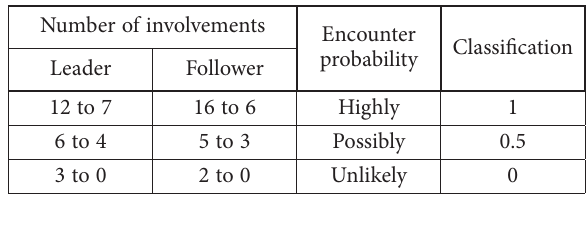
Table 1. Number of leaders and followers involvement in